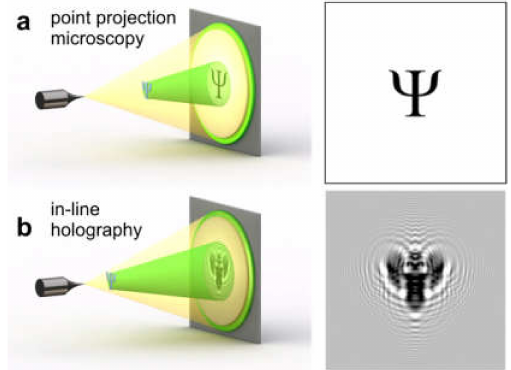
Figure 10. Point projection microscopy (PPM) and in-line holography. ( a ) Experimental arrangement for PPM and the resulting image. ( b ) Experimental arrangement for in-line holography and the resulting